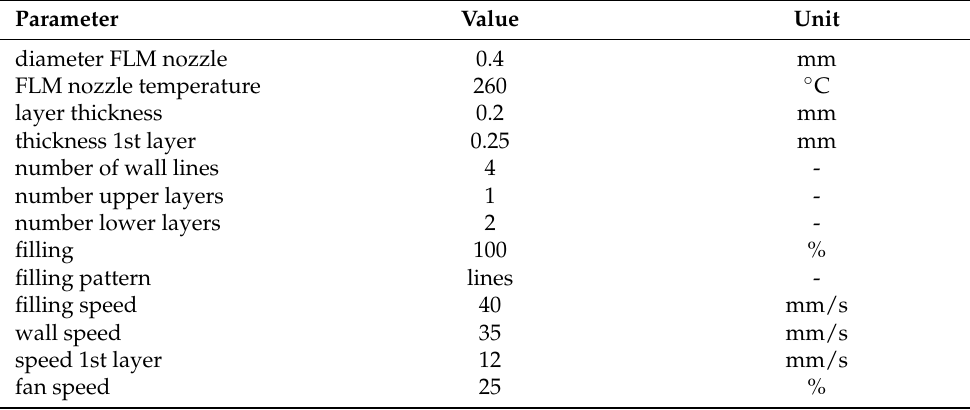
Table 4. Printing parameters for the test